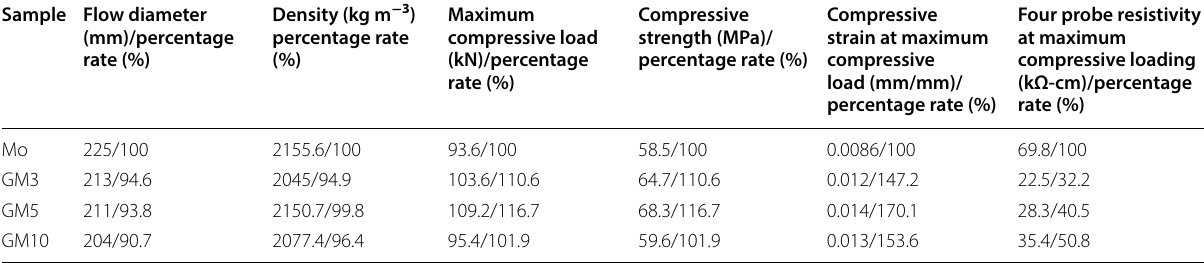
Table 14 Flow diameter, density, compressive strength, compressive strain and electrical resistivity values of various cement